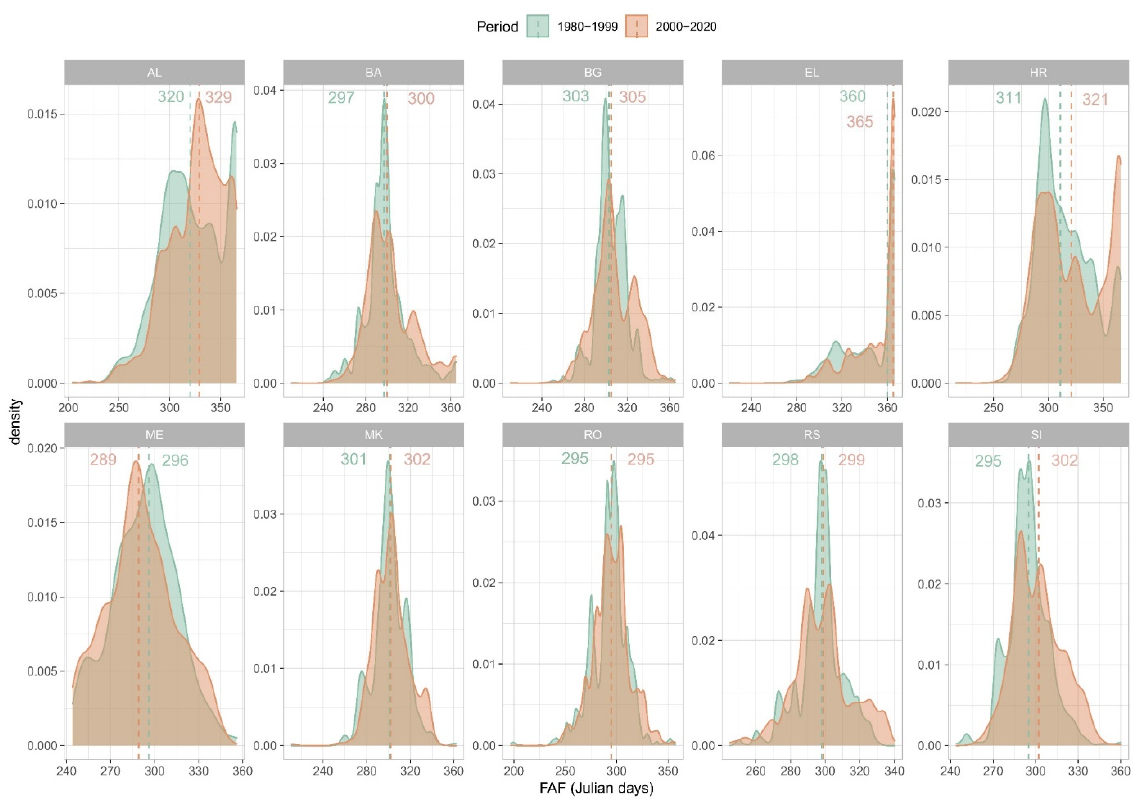
Figure 18. The first autumn frost (FAF) probability density per country for the 1980–1999 and the 2000–2020 time periods.